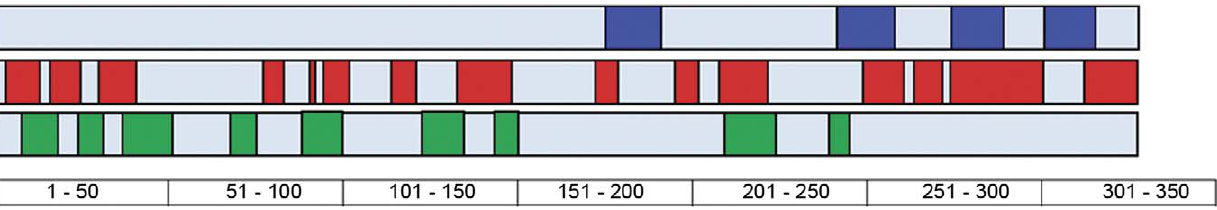
Figure 2. Comparative representation of conserved, variable and antigenic regions from rotaviral VP7 protein database. Comparative schematic diagram for conserved surface accessible region (blue), previously recorded antigenic regions from IEDB server (red) and variable regions of rotavirus (green). Here length of protein VP7 is 326 amino acids.